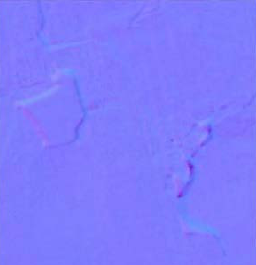
Figure 12. Representation of normals, where R,G,B channels depict the X, Y and Z normals.